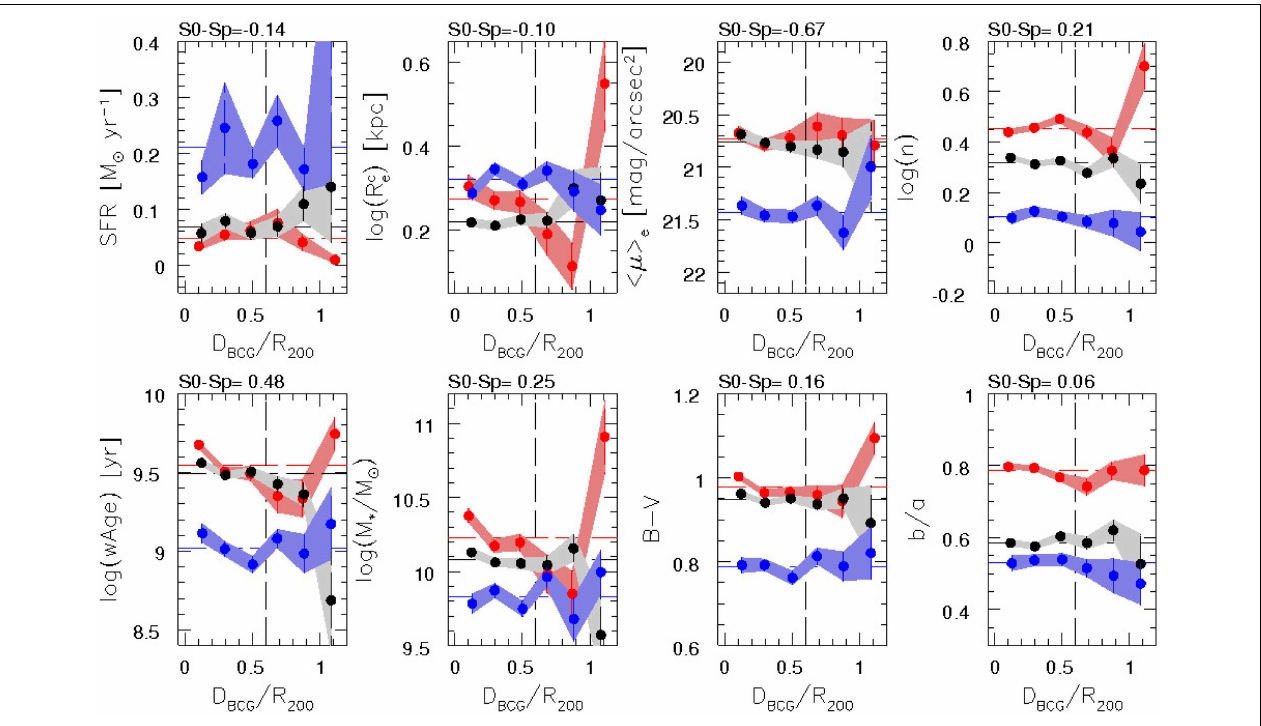
the B − V color, and the axis ratio ( b / a ). Red dots mark the Elliptical galaxies, black dots the S0 galaxies, and blue dots Spirals. The horizontal dashed lines provide the average value of the morphological classes, while the colored strips mark the width of the error of the mean. The vertical dashed lines mark the limits where the stacked sample is 50 % complete. ∼ On the top of each diagram we report the mean difference between the S0 and Spiral